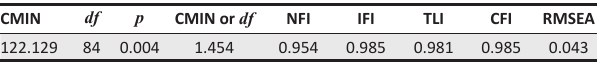
TABLE 4: Goodness-of-fit measures of the structural